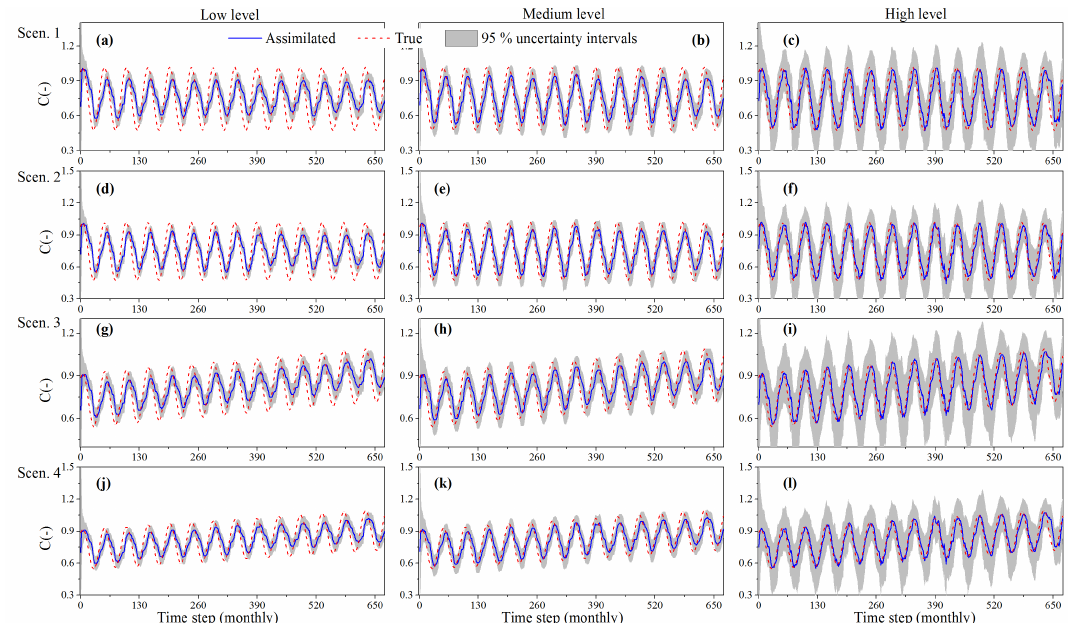
Figure 3. Comparison between estimated C and its true values for various parameter changes under different uncertainty levels. The gray areas represent the 95% prediction uncertainty